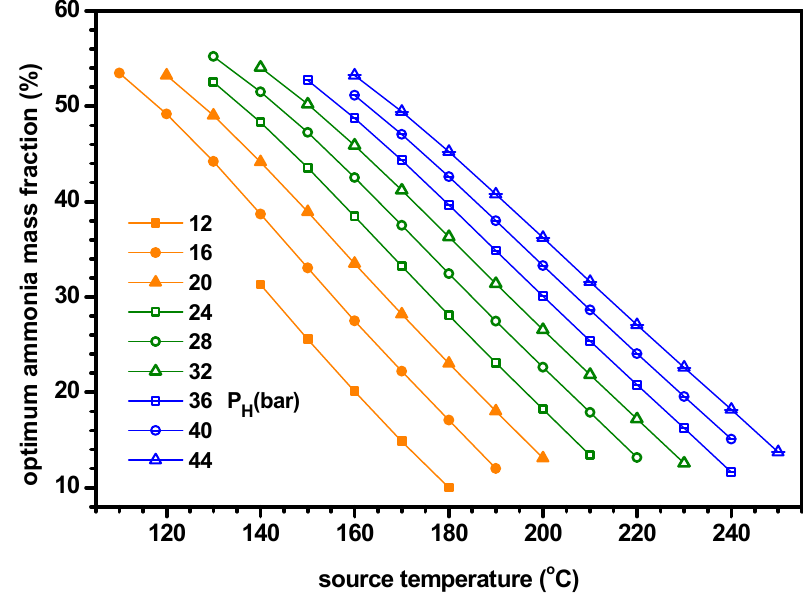
Figure 14. Effect of source temperature on the optimum ammonia fraction. Figure 14. E ff ect of source temperature on the optimum ammonia fraction.